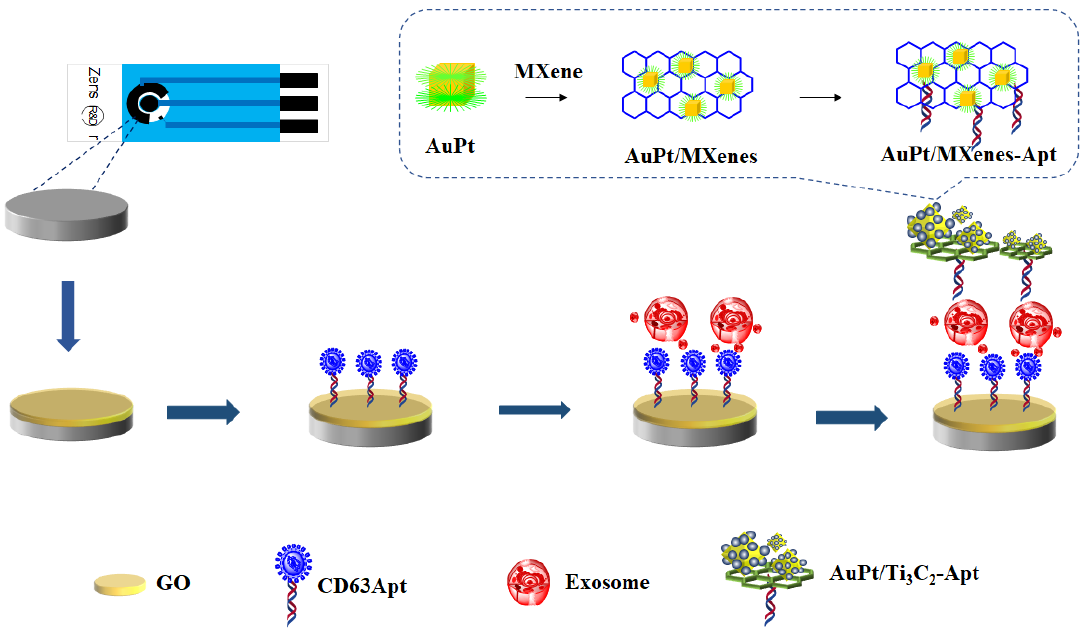
Figure 1. The schematic illustration of the fabrication procedure of the exosome electrochemical